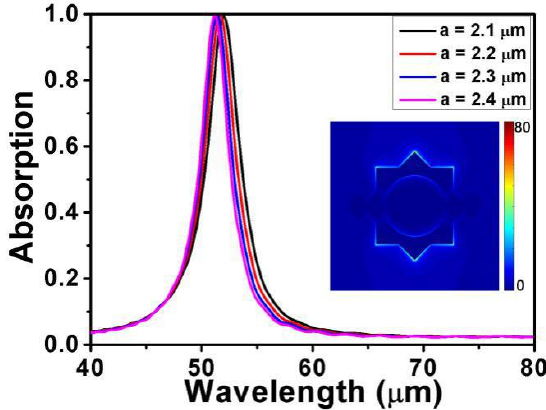
Figure 2. Absorption spectra for different values of period a . Other parameters remain fixed. The inserts indicate the distributions of the electric field (|E|) at a = 2200 nm.